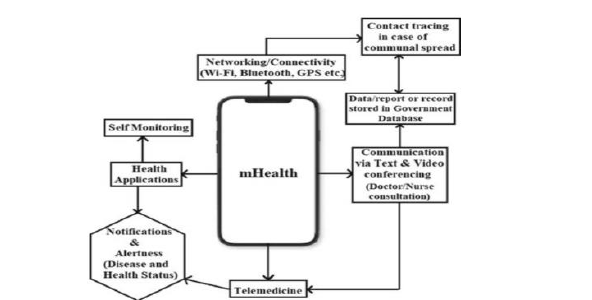
Figure 2. mHealth in Various Domains; explaining the importance of mHealth (Mobile health) and how it is working. (i) By text messaging and video conferencing, a patient can consult a doctor without travelling such a large distance and can get